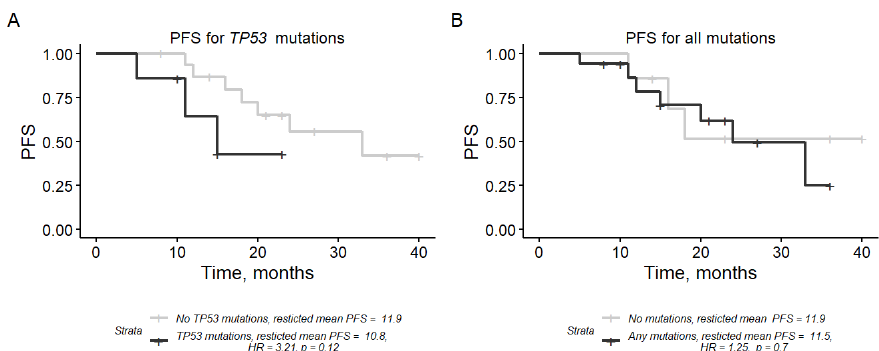
Figure 5. Kaplan-Mayer curves for progress-free survival (PFS) at 12 months stratified by uterine lavage mutations in ( A ) TP53 and ( B ) all genes. Restricted mean PFS is denoted in months. HR— hazard ratio, CI—confidence interval .